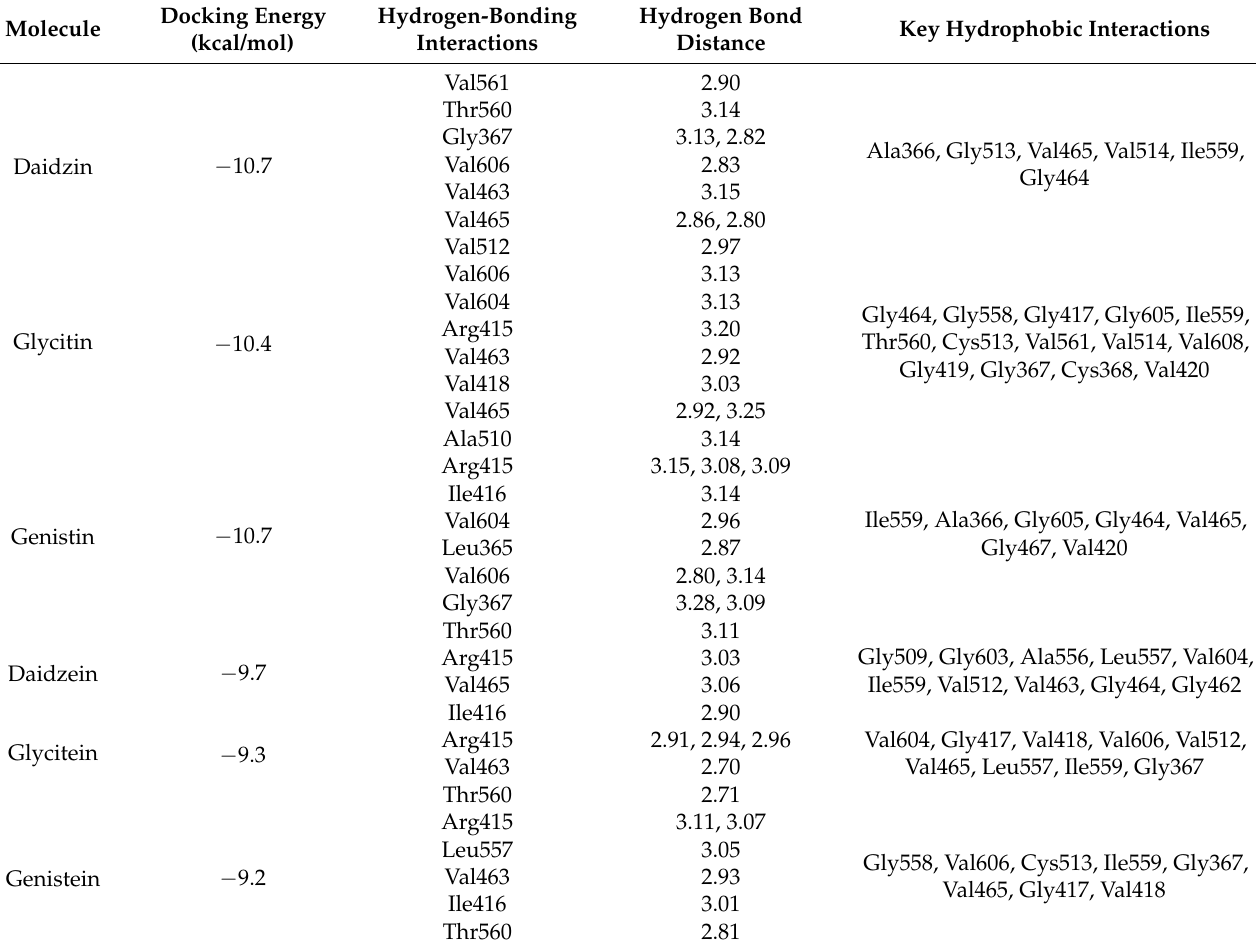
Table 1. Details of the docked complex of Keap1 with